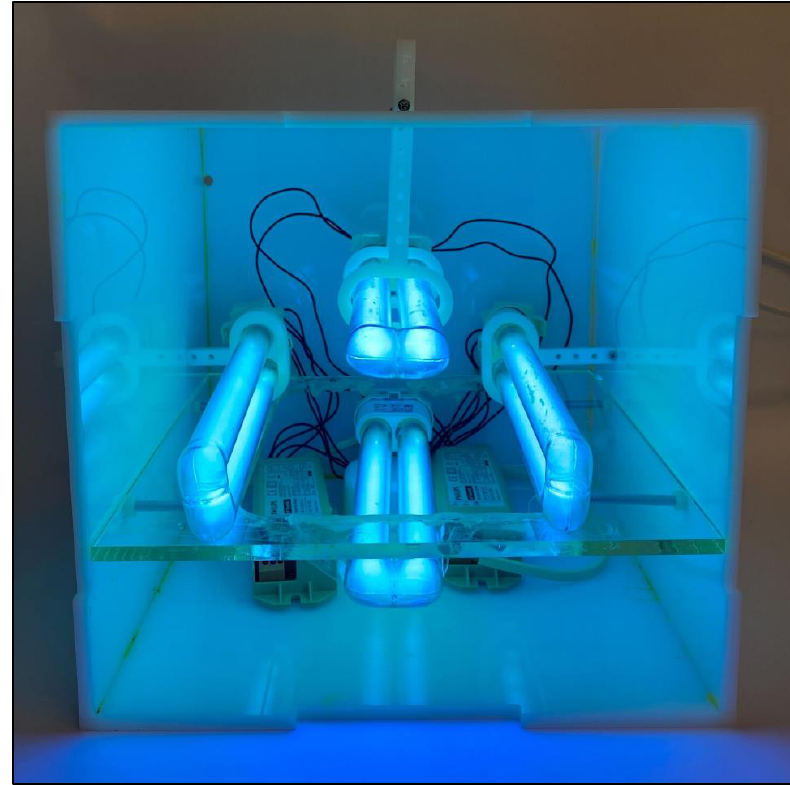
Figure 1 . The UV-C irradiation setup . Figure 1. The UV-C irradiation